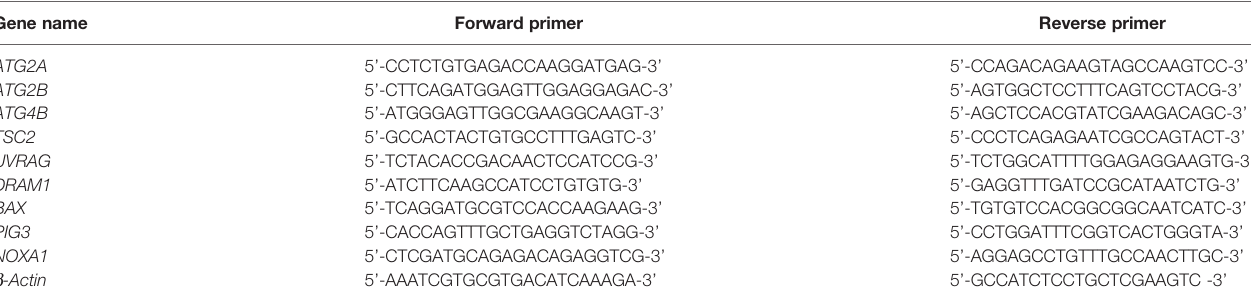
TABLE 1 | Sequences of primers for